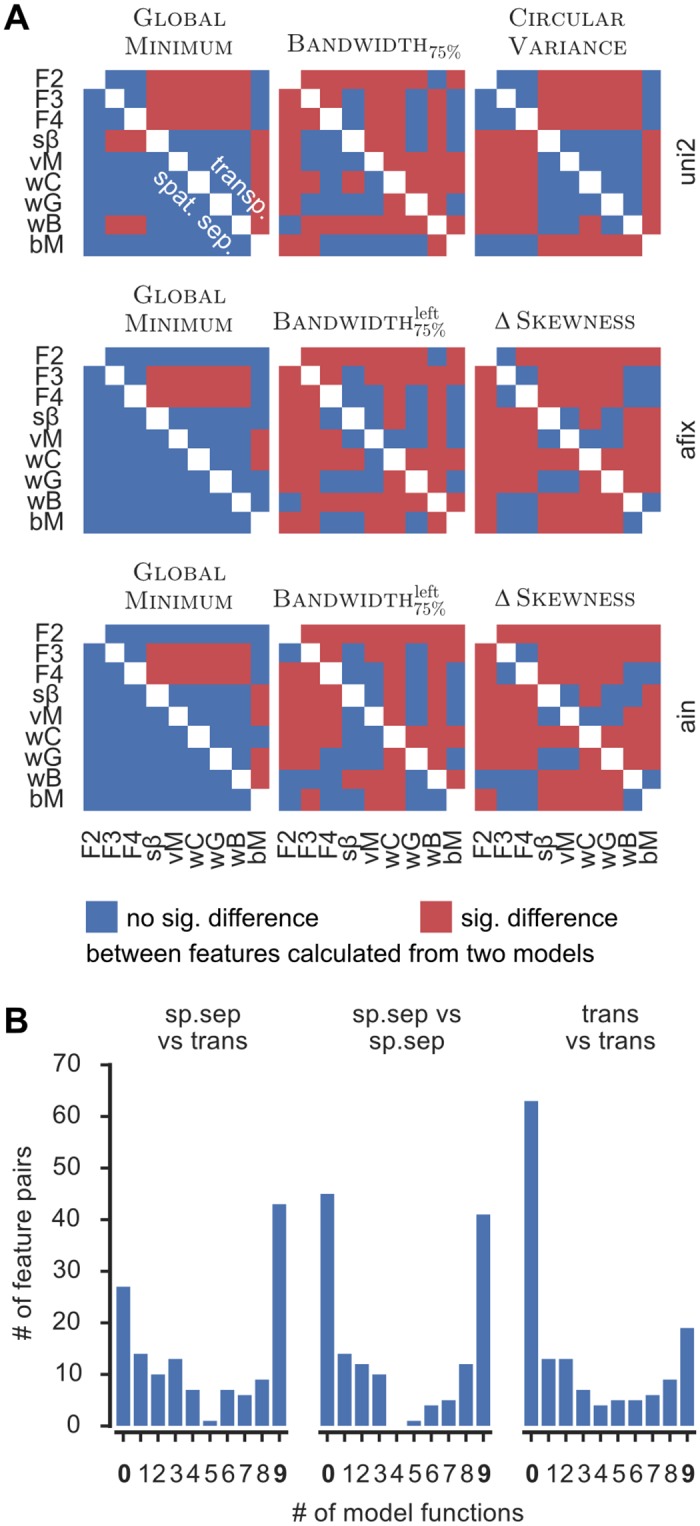
Effects found in the data depend on model.A) Nine features, measuring aspects of firing rate (first column), width (second column) and global shape (third column) in all three conditions were calculated for each cell on the basis of eight fitted models (model abbreviations are as in Fig 3) and the “best model” (according to the ΔAIC = 0 criterion, see main text; abbreviated “bM”). Red (blue) indicates a statistically significant (not sig.) difference between two models’ values of that feature. Results from the spatially separated and transparent paradigm are plotted below and above the diagonal, respectively. The panels indicate that, in general, models disagree on the value of a feature, and, in particular, might contradict the optimal (bM) model. B) Histograms count for all feature pairs (depending on their category “sp.sep vs trans”, “sp.sep vs sp.sep” or “trans vs trans”) the number of model functions that find a significant difference (“effect”) between the pair. While mostly all models agree (counts 0 and 9) there are also numerous cases in which the presence of an effect depends on the chosen model.